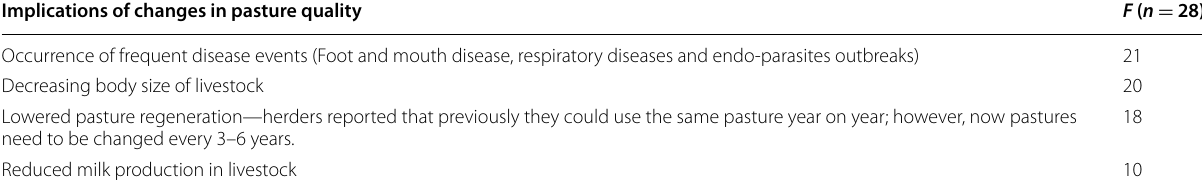
Table 6 Frequency ( F ) of implications of changes in pasture quality, based on interviews with 28 migratory herders Implications of changes in pasture